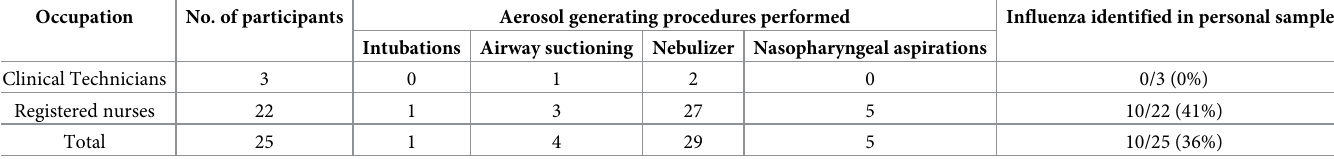
Table 6. Influenza identified in personal bioaerosol samplers after performing aerosol generating procedures.